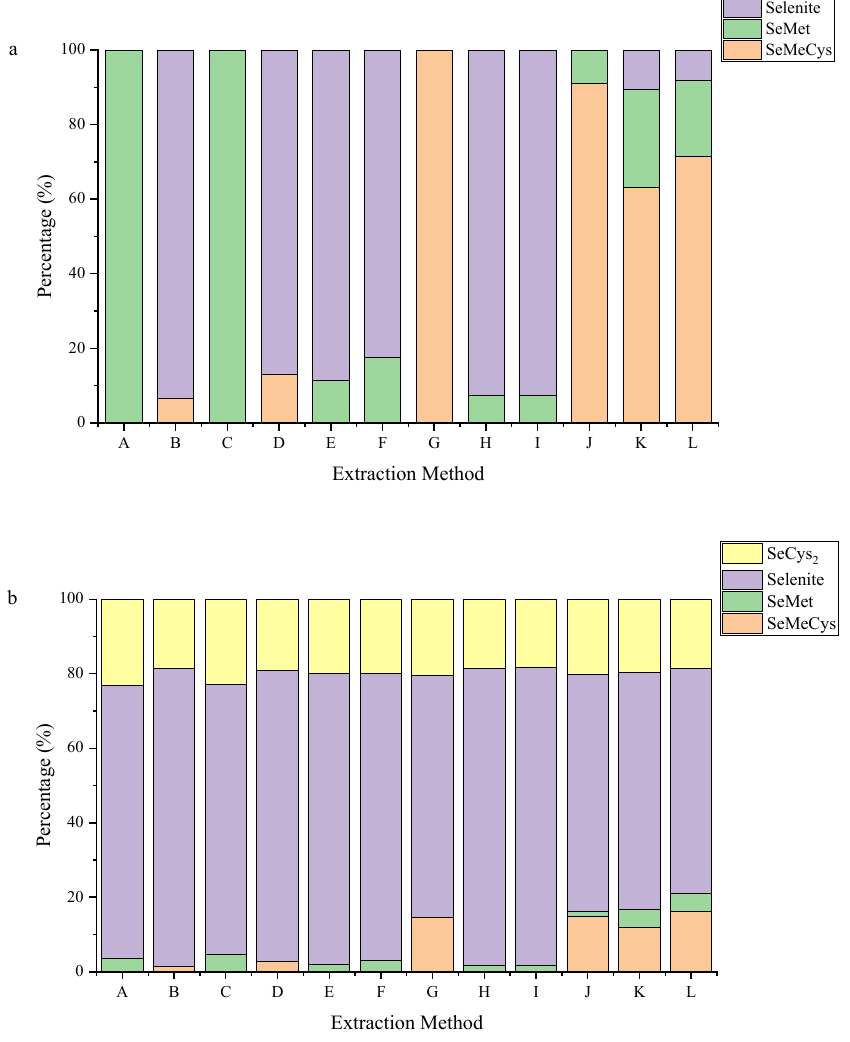
Figure 3. ( a ): Se speciation distributions in high Se-enriched G. lucidum via 12 sequential extraction methods (100% refers to total organic Se detected in sequential extraction); ( b ): Se speciation dis- tributions (including the selenium speciation in the preliminary ball milling) in high Se-enriched G. lucidum (100% refers to total organic Se detected during the whole process) (Note: A-Phosphate (pH 7.5), trypsin; B-Phosphate (pH 7.5), protease XIV; C-Tris-HCl (pH 7.5), trypsin; D-Tris-HCl (pH 7.5), protease XIV; E-Tris-HCl (pH 7.5), protease K; Phosphate (pH 7.5), protease XIV; F-Tris-HCl (pH 7.5), protease K; Tris-HCl (pH 7.5), protease XIV; G-Glycine (pH 2.1), pepsin; Phosphate (pH 7.5), trypsin; H-Phosphate (pH 7.5), protease K; Phosphate (pH 7.5), protease XIV; I-Phosphate (pH 7.5), protease K; Tris-HCl (pH 7.5), protease XIV; J-Glycine (pH 2.1), pepsin; Tris-HCl (pH 7.5), trypsin; K-Tris-HCl (pH 2.1), pepsin; Phosphate (pH 7.5), trypsin; L-Tris-HCl (pH 2.1), pepsin; Tris-HCl (pH 7.5),